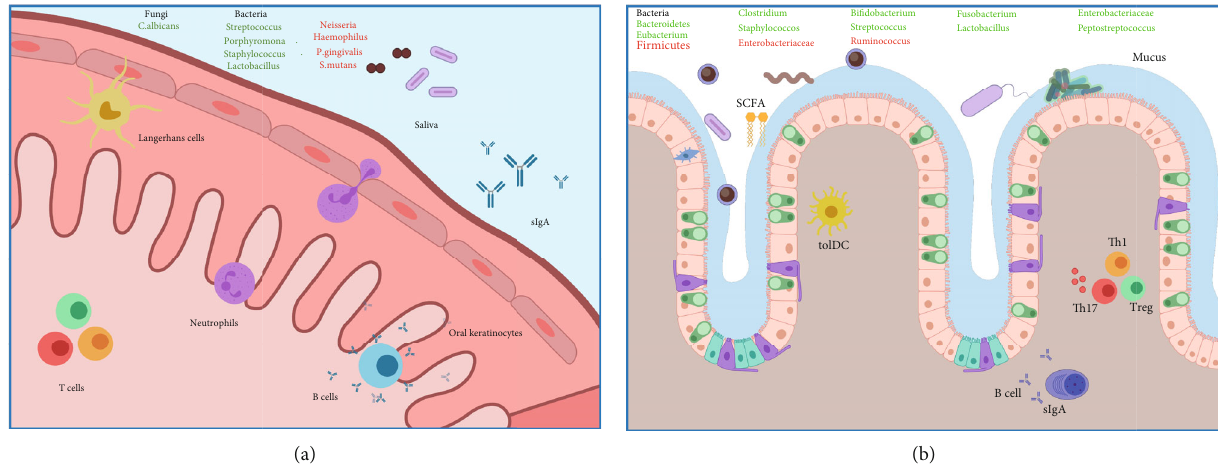
Figure 2: Oral and gastrointestinal microbiota. (a) The composition of oral microorganisms is implicated in maintaining homeostasis to keep the oral cavity in good health. Dysbiosis (red microorganisms) is associated with disease, but in addition, it can functionally contribute to the etiology, diagnosis, or treatment of the disease. (b) Metabolites derived from commensal bacteria interact with enterocytes and other intestinal cells. T cells localize in inguinal lymph nodes promoting class-switch and the production of secretory IgG by B cells. In dysbiosis and disease, pathogenic bacteria (in red) increase their abundance and induce a proin fl ammatory